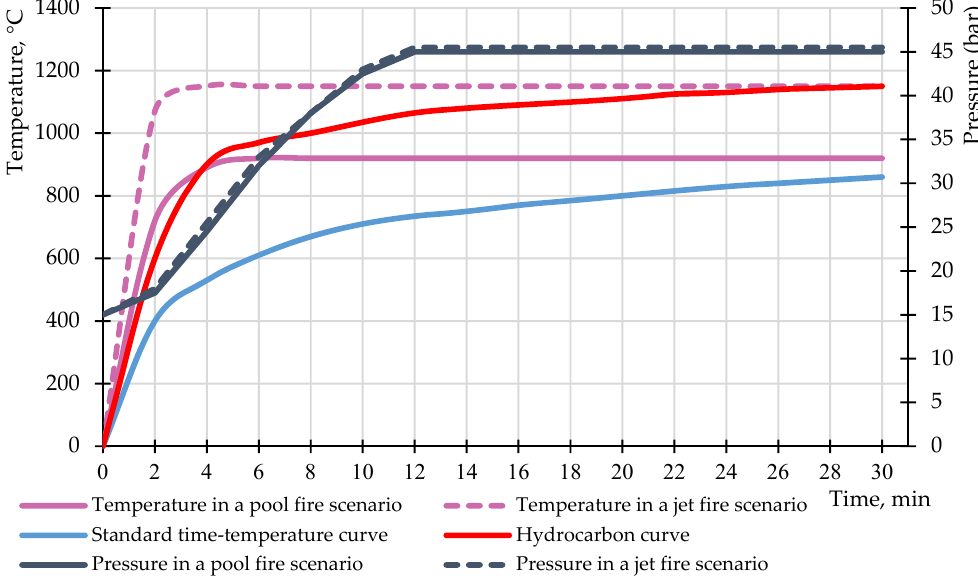
Figure 1. Results for 0.5 m diameter vessel with 45 bar design pressure of two types of fire: pool fire and jet fire [21].